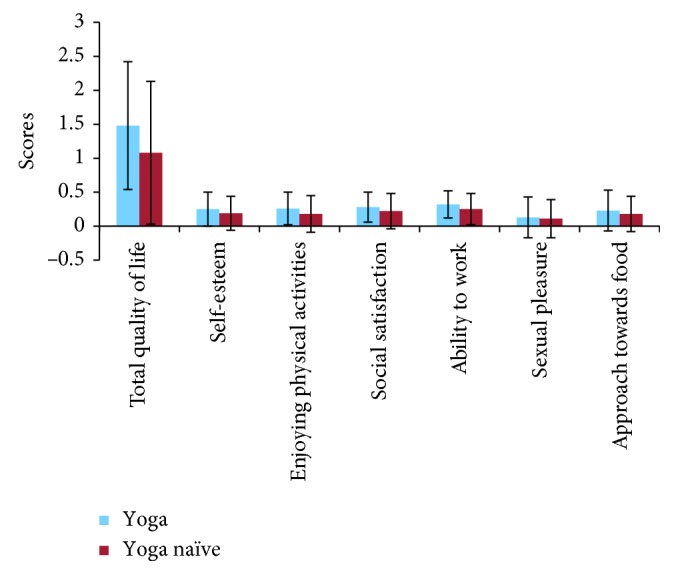
Graphical presentation of adjusted mean scores of quality of life of the yoga experienced and yoga naïve obese adults. Error bar showing the standard deviation of the quality of life scores.